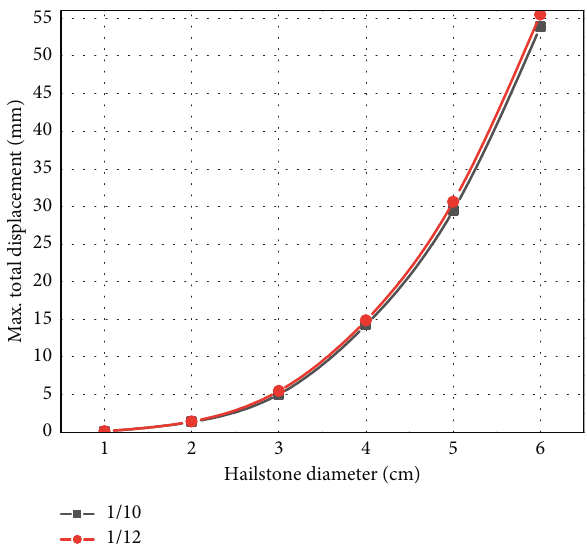
Figure 10: Total displacement curves of the impact point when the pretension level is 3000N/m and arch-to-span ratio is 1/12 and 1/